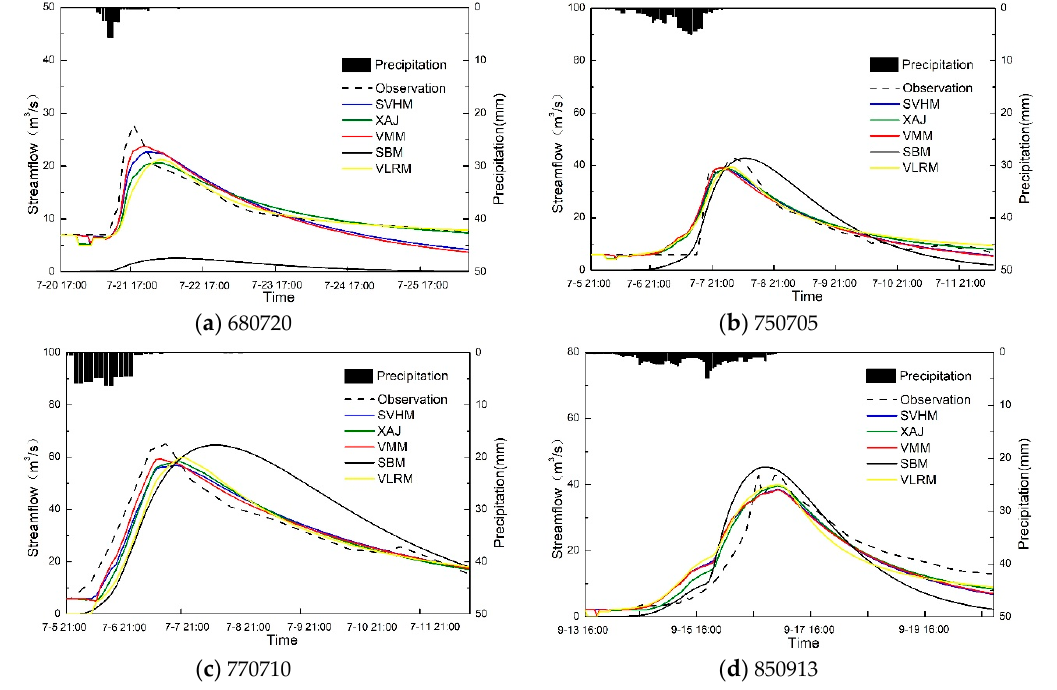
Figure 6. Comparisons of simulated and observed streamflow for some flood events in Xiuwu Basin ( a , b are calibration and c , d are validation).